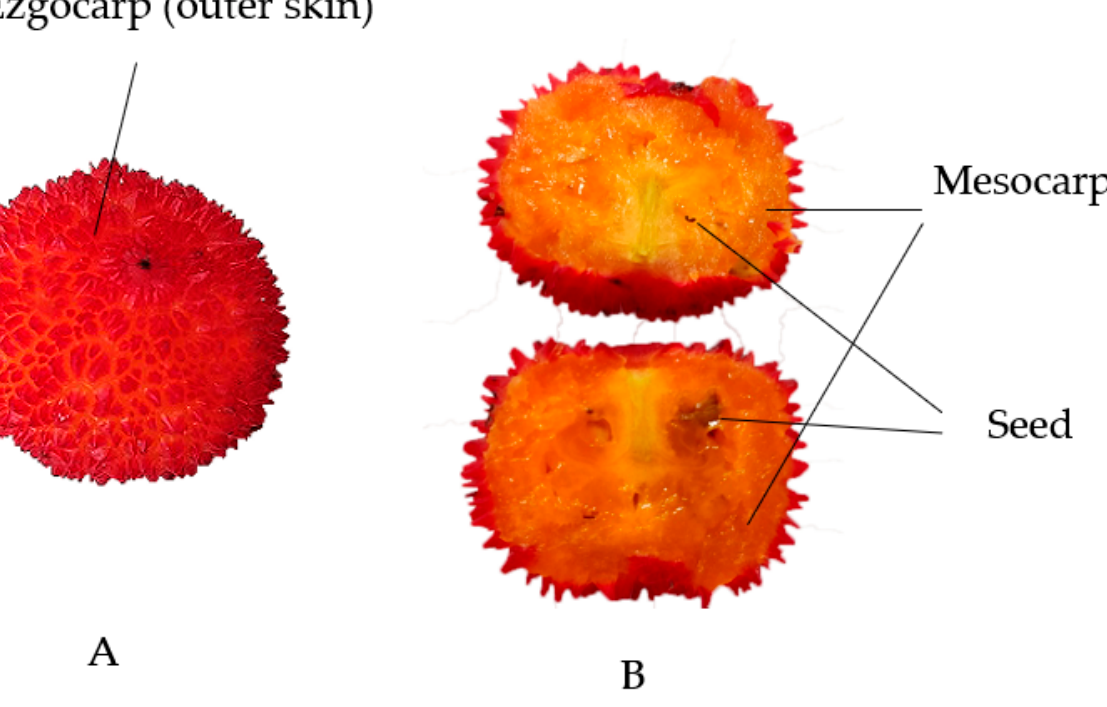
Figure 1. Strawberry tree ( Arbutus unedo L.) fruit: ( A ) the whole fruit, and ( B ) cross section.